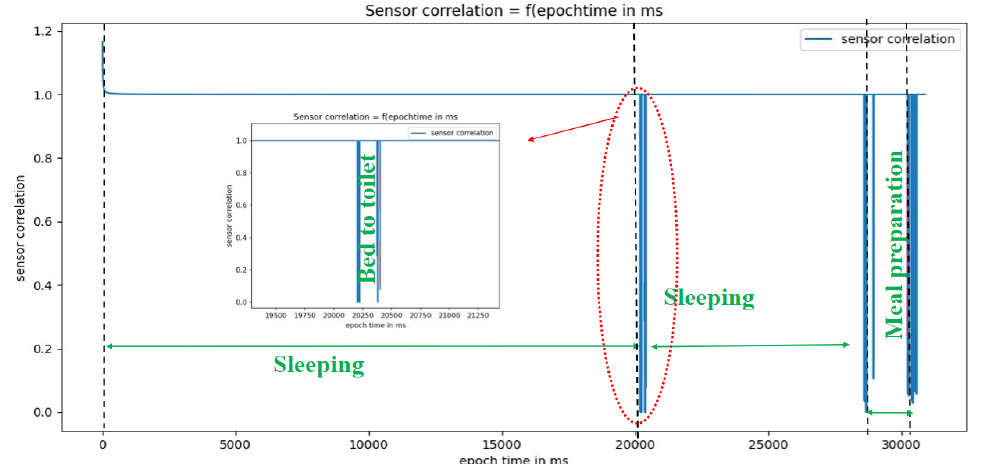
Figure 15. Segmentation of the activities sleeping, bed to toilet, and meal preparation.